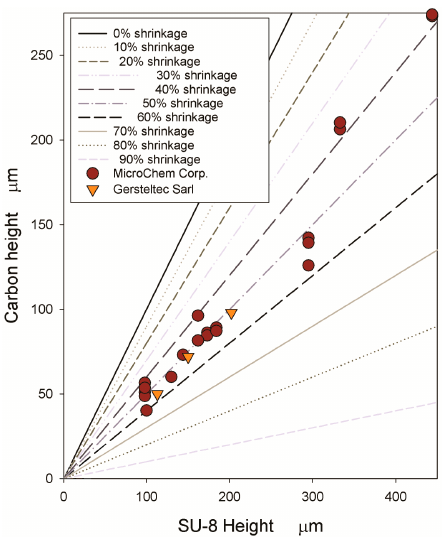
Figure 3. The relation between the height of carbon structures and their SU-8 precursors when using SU-8 2150 from MicroChem (circles) and GM1075 from Gersteltec (downward triangles). Lines denote different degrees of shrinkage, from 0% to 90%. Note how shrinkage decreases as thicker structures are